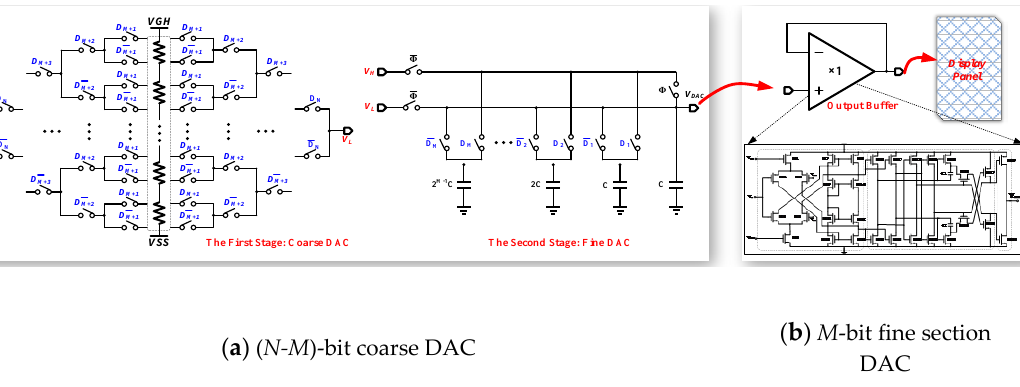
Figure 2. The schematic diagram of a typical N -bit two-stage resistor-to-capacitor digital-to-analog converter (R-C DAC) consisting of ( a ) ( N-M )-bit coarse DAC and ( b ) M -bit fine section DAC.